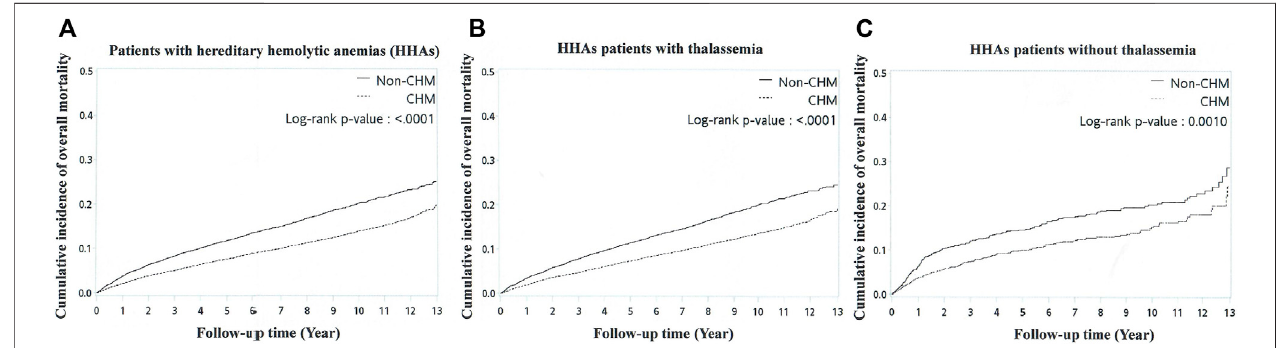
FIGURE 3 | Kaplan-Meier curves for overall mortality for patients with HHAs (A) with/without thalassemia (B,C) . Abbreviations: HHAs, hereditary hemolytic anemias.